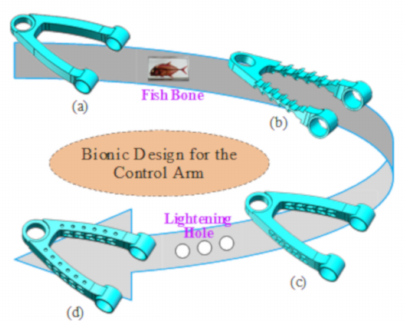
Figure 13. The design idea of bionic sub-branch: ( a ) the main-branch of control arm; ( b ) the bionic model with fish bone; ( c ) the bionic model with skin; ( d ) the final bionic model.